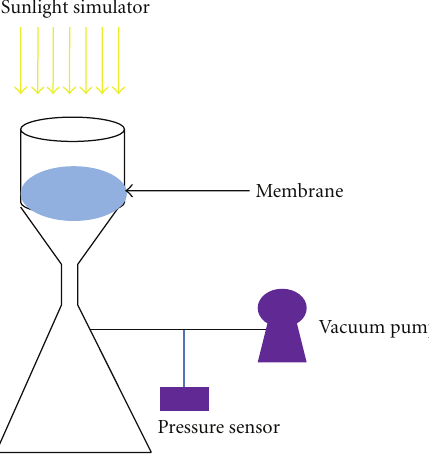
Scheme 1: Schematic setup for membrane assembly and pho- todegradation of